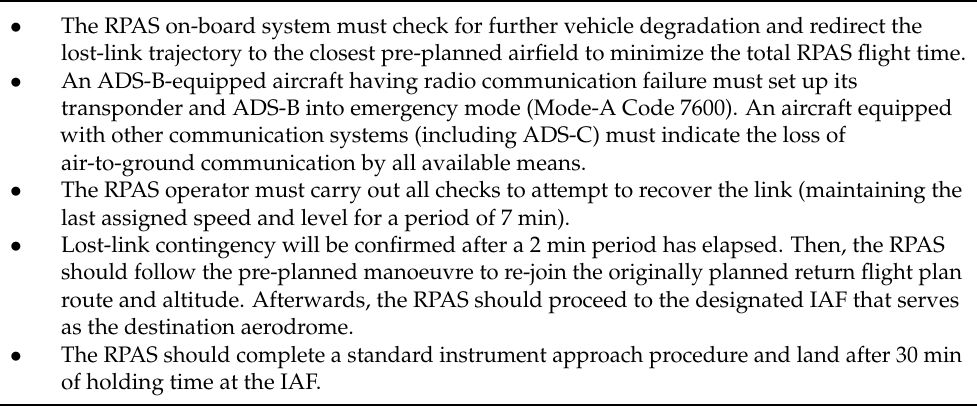
Table 2. Flight-specific procedures for a C2 lost link or general loss of